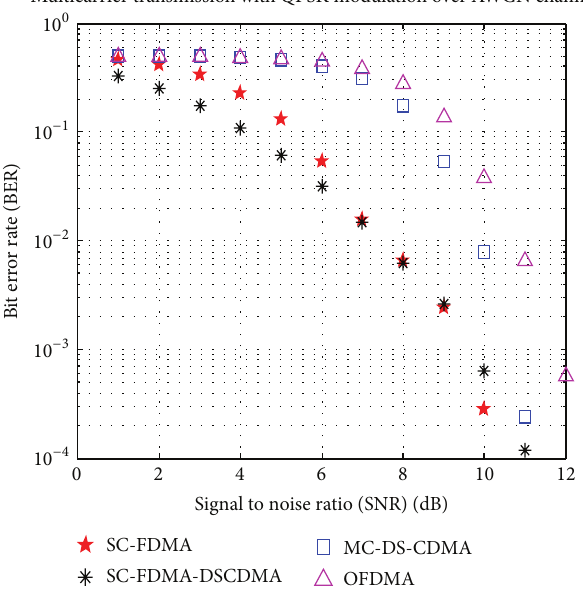
Figure 2: BER performance of the proposed SC-FDMA-DSCDMA technique compared with other multicarrier techniques (over AWGN channel). BER performance of the proposed technique is best and very close to that of SC-FDMA and Luo and Xiong [5]. No degradation in BER.